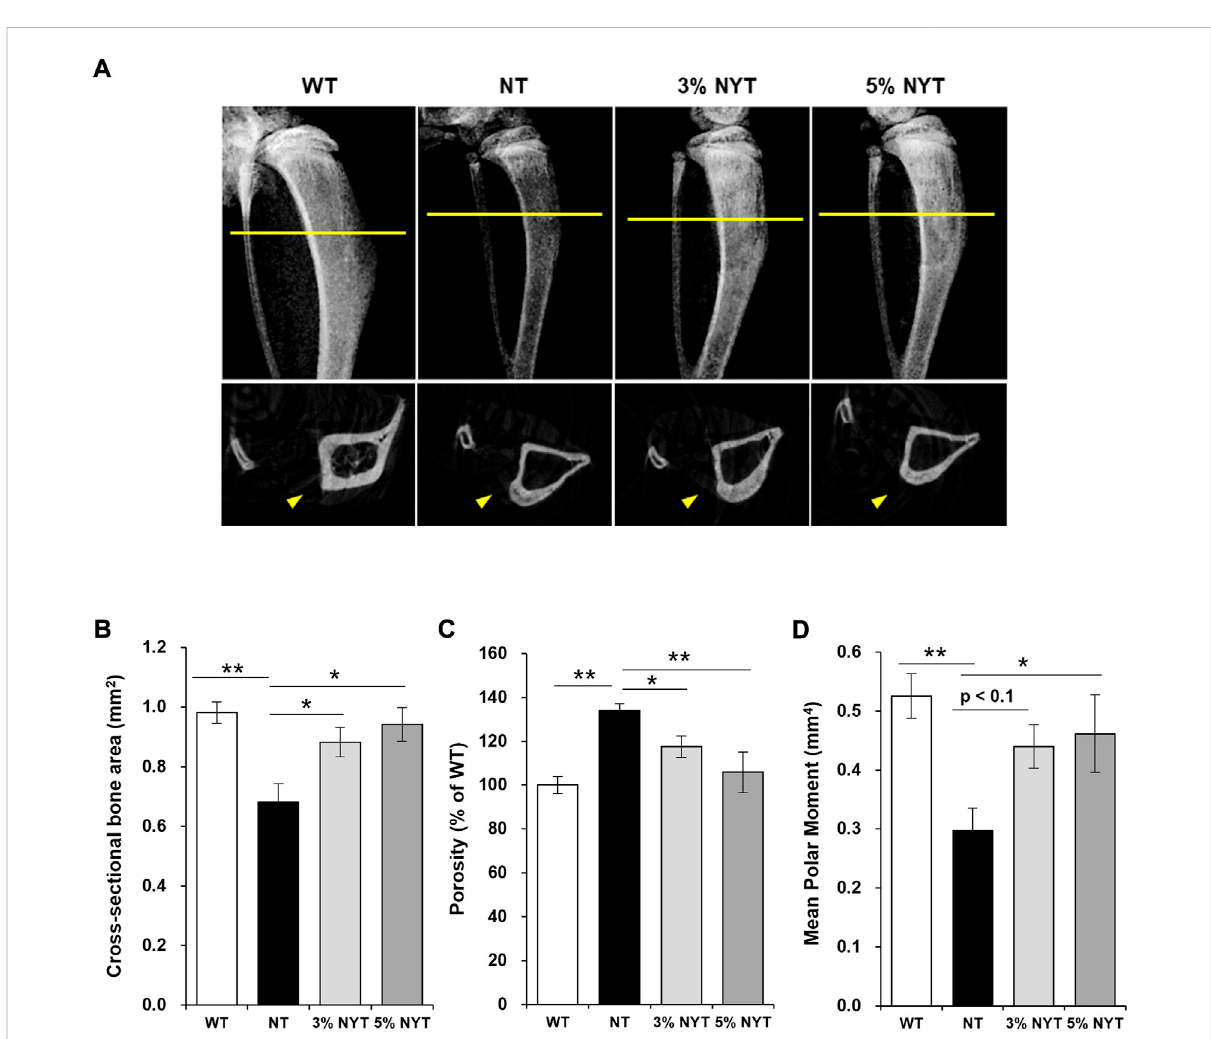
FIGURE 5 X-ray image of the dissected tibia of hindlimb ( A , upper) and slice images of micro-CT scan ( A , lower) on 59 days old are shown. The radiation absorption values of the both bones were analyzed by CT analyzer software, and determined the Cross sectional bone area (B) and Porosity (C) and MeanPolarMoment (D) ofcorticalbone.DataareindicatedasmeanandSEMvalues.Signi fi cantdifferencesarepresentedonhistograms:[* p < 0.05, ** p < 0.01, Dunnett ’ s contrast, WT ( n = 4), NT (8), 3% NYT (6), 5% NYT